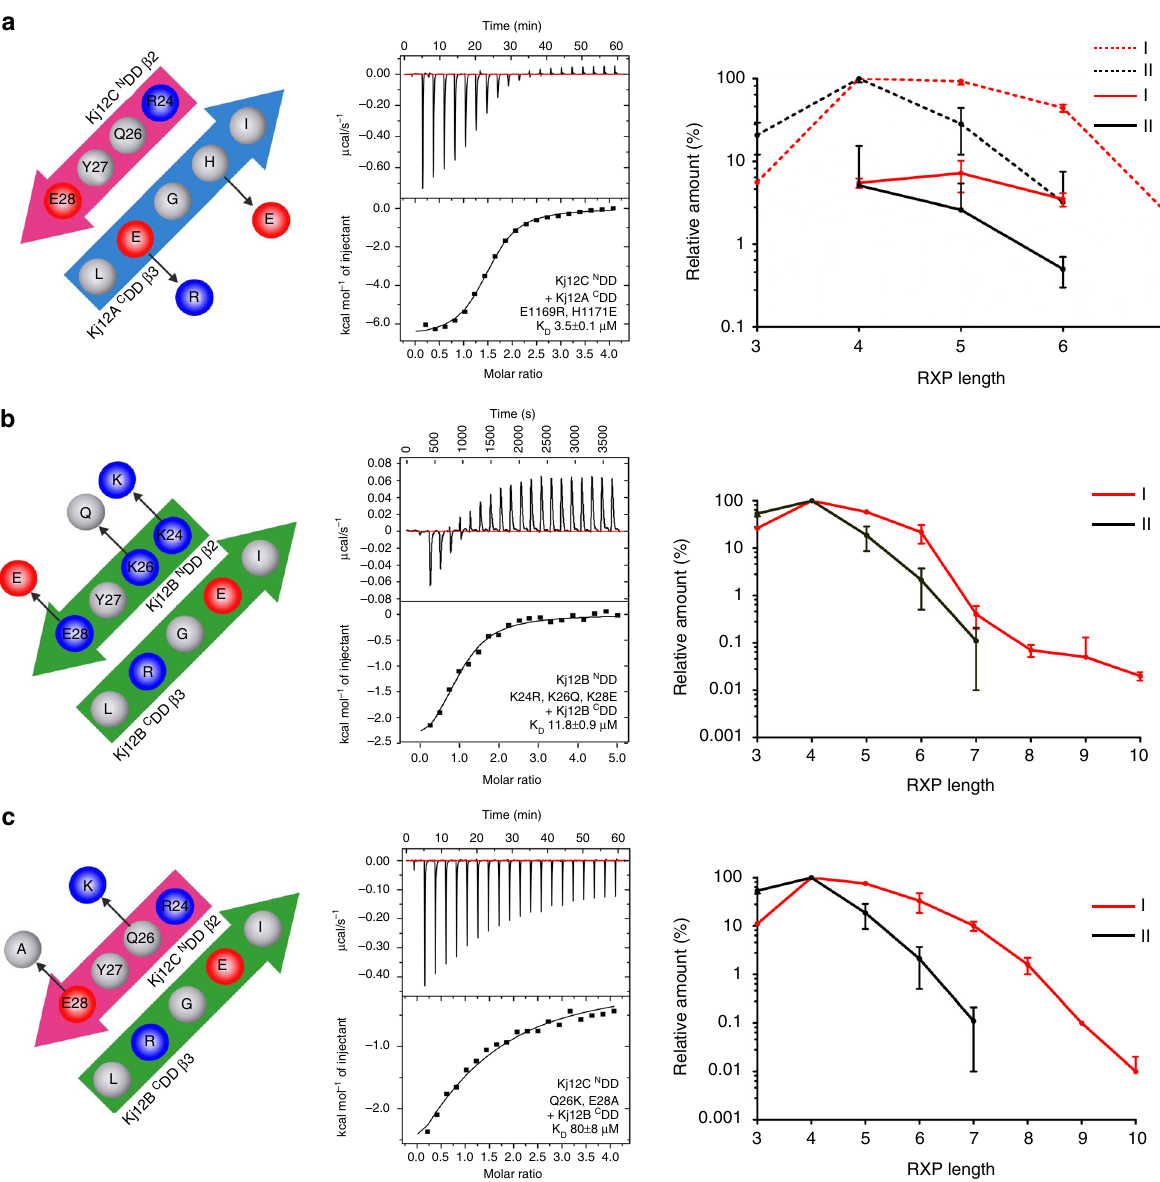
Fig. 5 Optimization of C DD or N DDs in Kj12ABC system for the production of longer RXPs. Additionally, the ITC thermograms and the derived binding curves for titrations between optimized C DD or N DDs variants are shown. a Kj12A- C DD was optimized by two amino acid exchanges, E1169R and H1171E, on Kj12A- C DD. Co-expression of natural Kj12B with optimized Kj12C led to increased production of longer RXPs. Red lines (I) represent RXP production in the modi fi ed system, black lines (II) represent RXP production in the natural Kj12BC. Solid lines indicate fully methylated Val (mV) RXPs, dashed lines indicate RXPs containing only one non-methylated Val. b Optimization of Kj12B- N DD for tighter interaction with Kj12B- C DD via three amino acid exchanges, K26Q, K24R and K28E, on Kj12B- N DD. A red line (I) represents RXP production in the optimized system, a black line (II) represents RXP production in the natural Kj12BC. Only fully methylated RXPs are shown. c In addition to amino acid exchanges in b , Kj12C- N DD was additionally modi fi ed via two amino acid exchanges, Q26K and E28A, to reduce the interaction with Kj12B- C DD and allowing better interaction between Kj12B- N DD and Kj12B- C DD. No RXPs were detected after co-expression of natural Kj12B and modi fi ed Kj12C- N DD probably due to very weak af fi nities. A red line (I) represents RXP production in the optimized system, a black line (II) represents RXP production in natural Kj12BC. Only fully methylated RXPs are shown. x Axis, numbers of amino acid residues in RXPs (RXP length). y Axis, production of the corresponding RXPs relative to the most abundant derivative set to DD reprogramming results in peptide diversi fi cation in vivo .